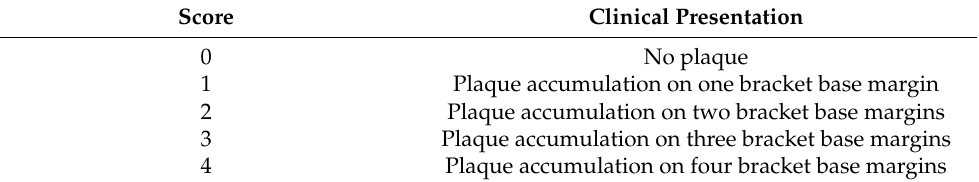
Table 1. Scores assigned to